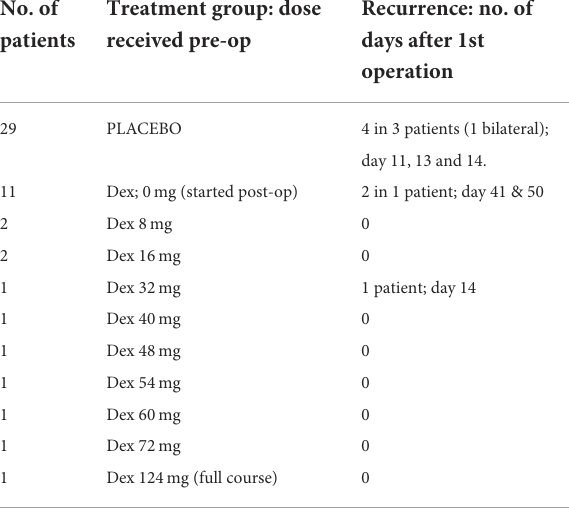
TABLE 2 Treatment groups and chronic subdural recurrence (Dex = dexamethasone). No.